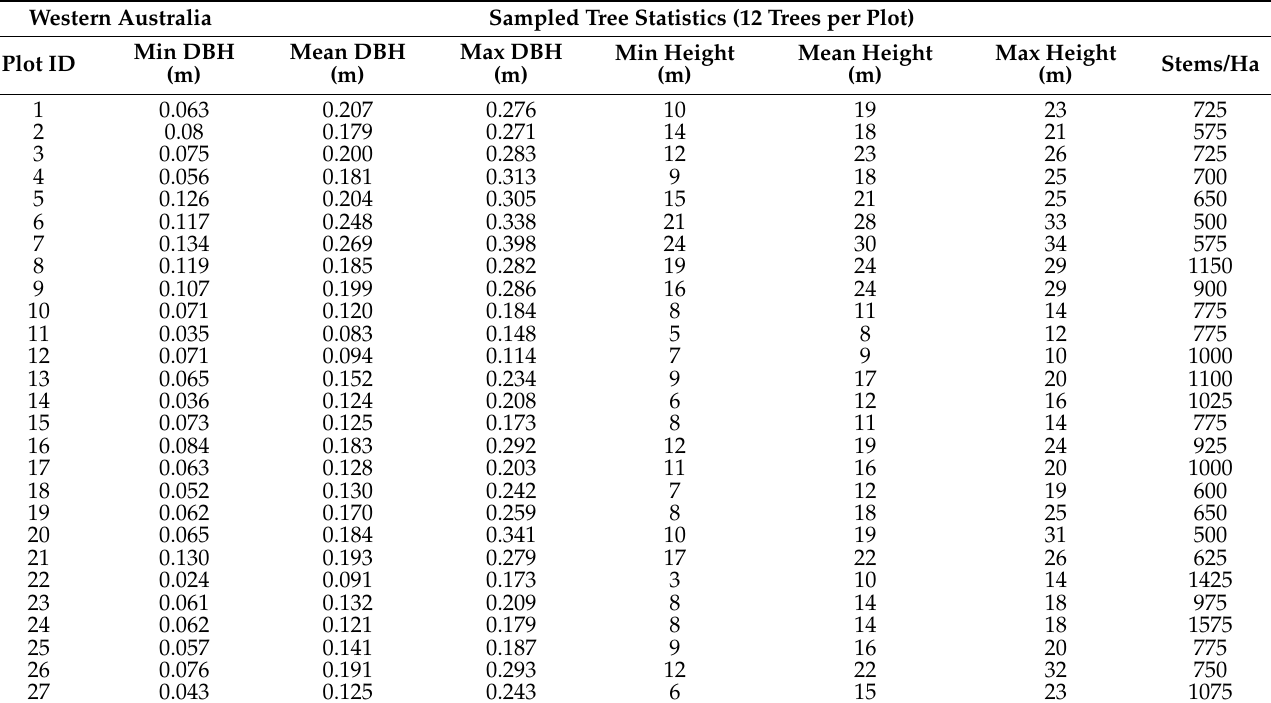
Table 1. Sampled stem statistics for the 27 Western Australia plots. Western Australia Sampled Tree Statistics (12 Trees per